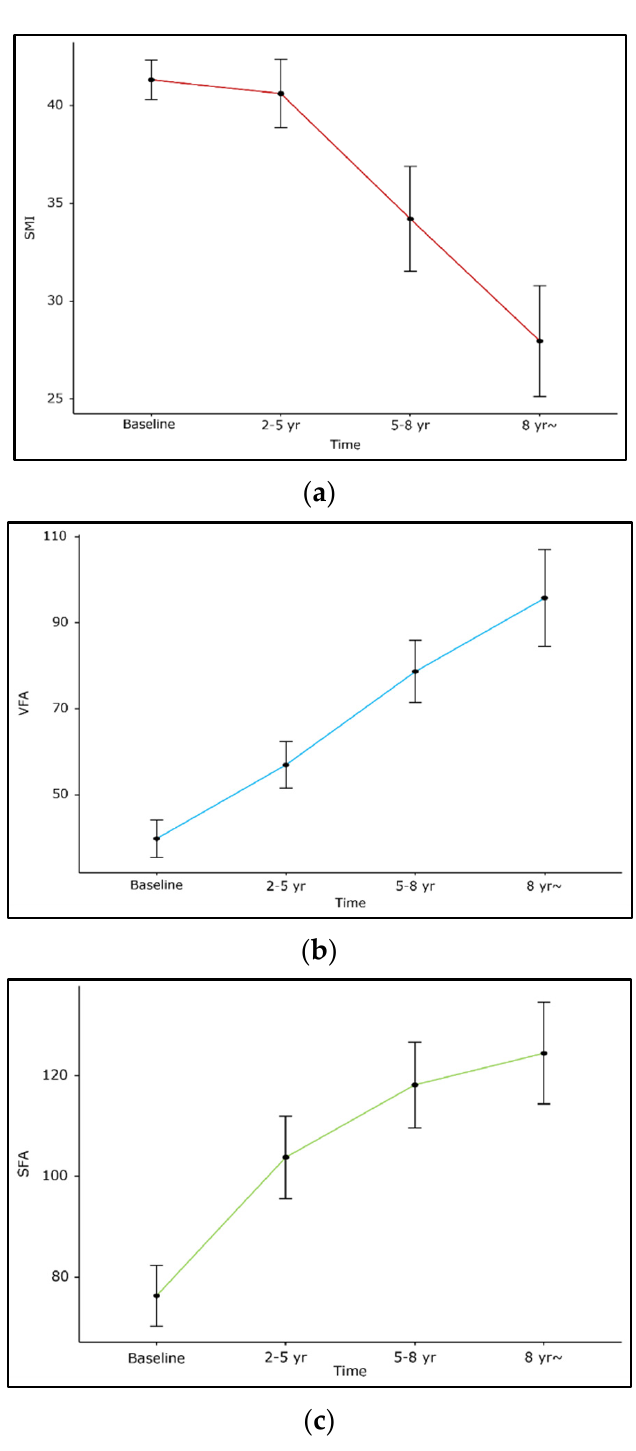
Figure 1. Changes in body composition during treatment follow-up in patients with Crohn’s disease. ( a ) SMI, ( b ) VFA, ( c ) SFA.